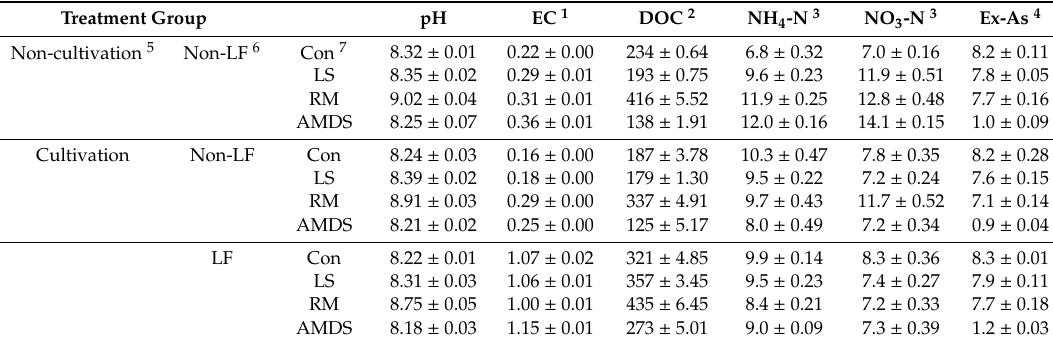
Table 2. E ff ects of treatments on soil chemical properties.